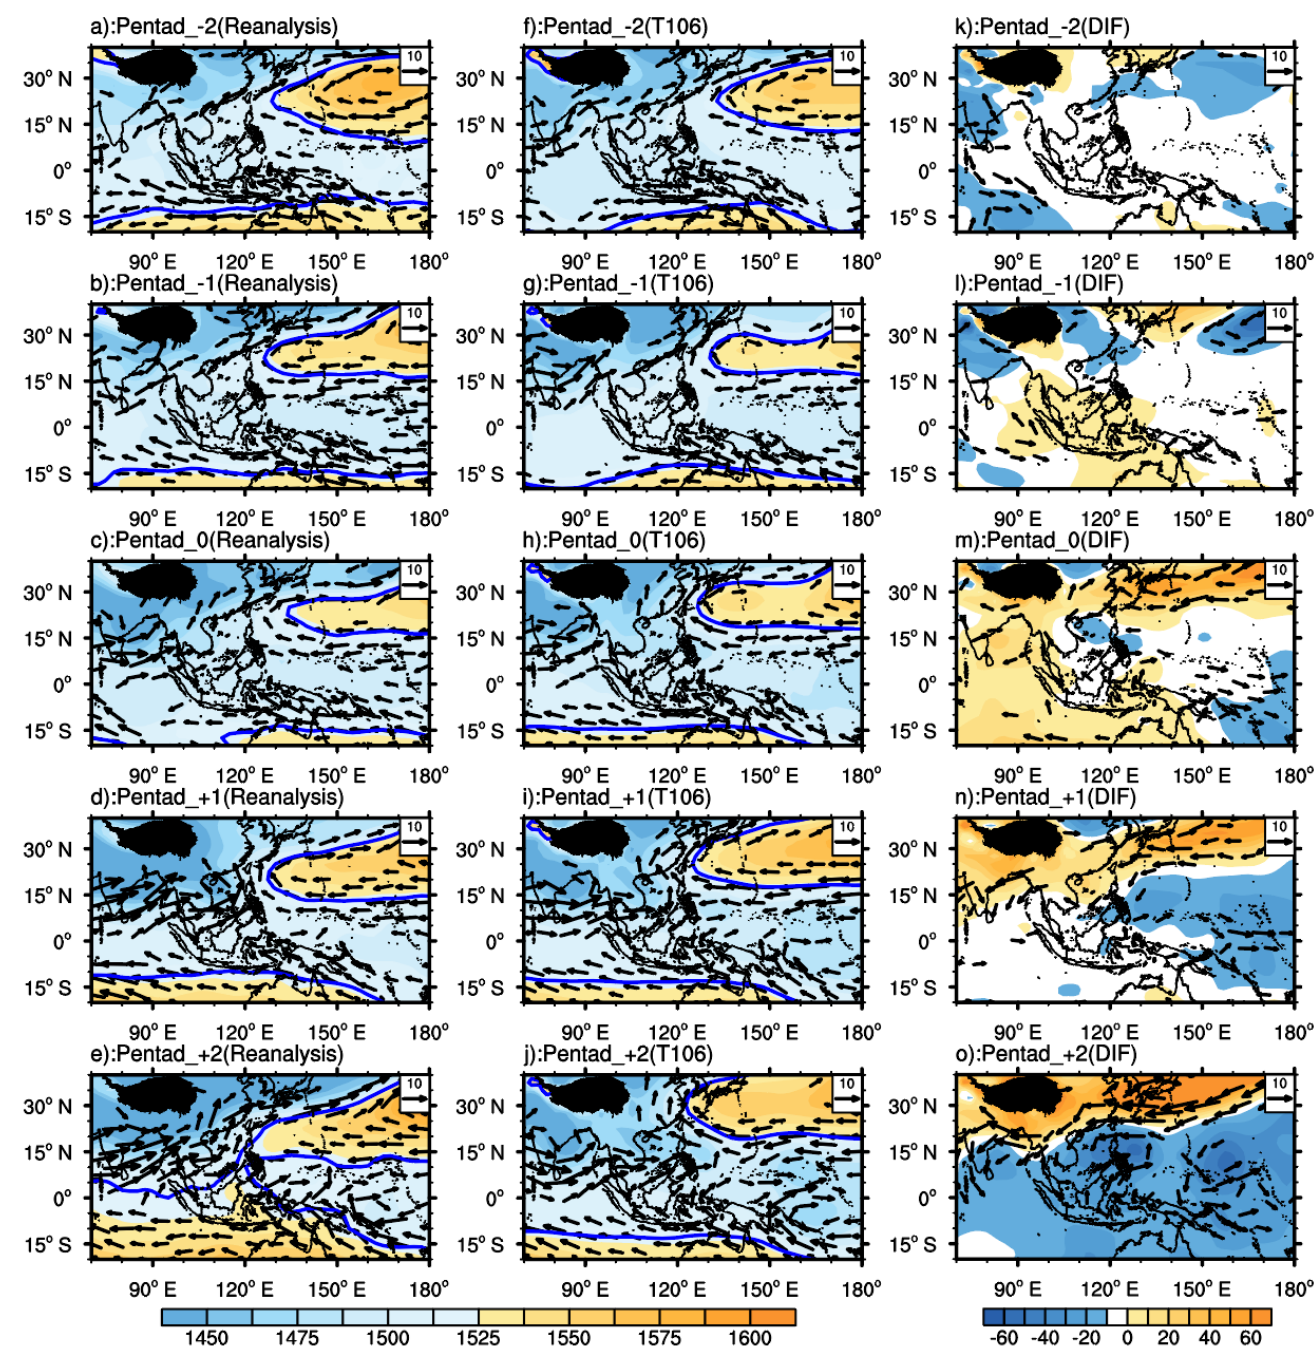
Figure 9. The mean wind (vector; unit: m.s −1 ) and hgt (shading; unit: gpm) at 850 hPa for 2015 with earlier predictions of T106. ( a − e ): reanalysis; ( f − j ): prediction, ( k − o ): difference between predictions and reanalysis. Pentad_0 illustrates the onset date based on reanalysis; Pentad_+ ( − )1,2 states the pentad later (earlier) than Pentad_0 for one or two pentads. Only wind with speed of above 5 m s −1 is plotted. The blue contour of 1520 gpm denotes the WPSH.